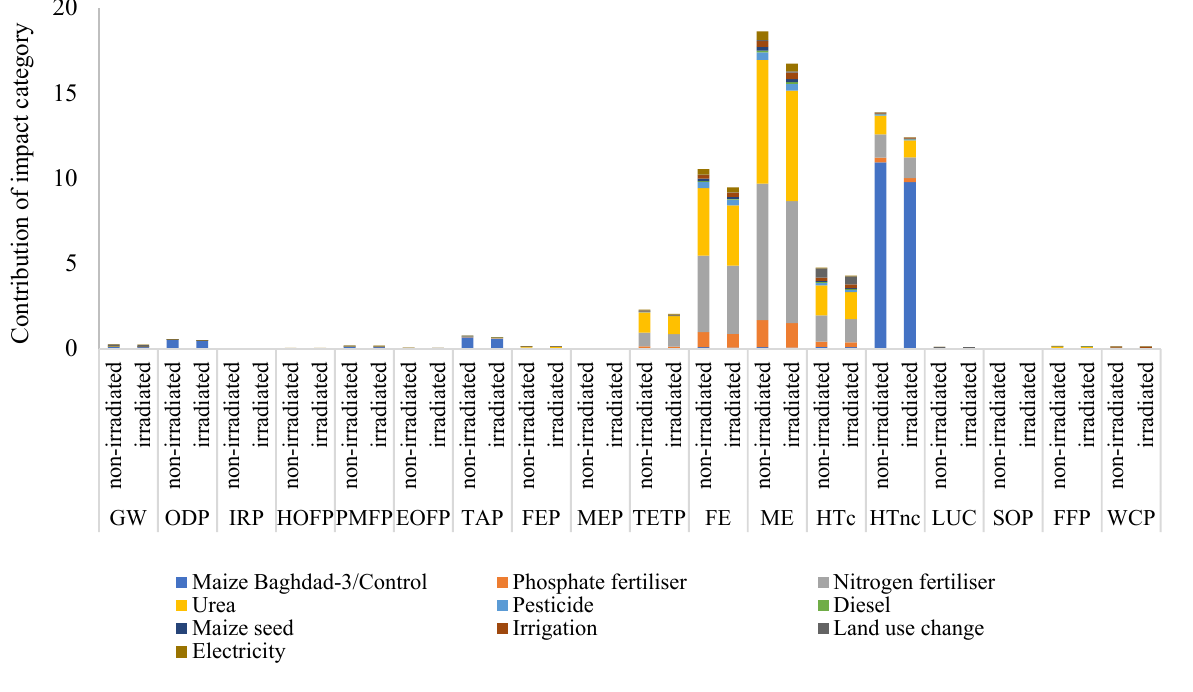
Figure 2. Results of normalization for maize production irradiated by laser (IL) and non-irradiated (NIL) using ReCiPe 2016.